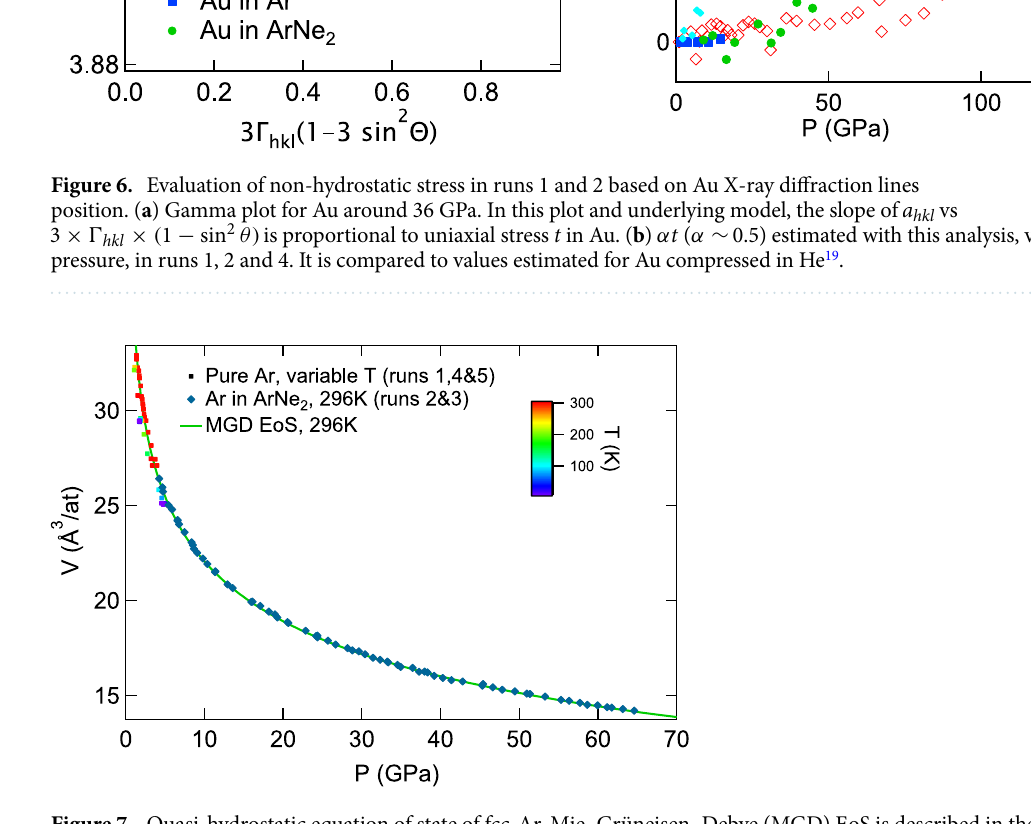
Figure 7. Quasi-hydrostatic equation of state of fcc-Ar. Mie–Grüneisen–Debye (MGD) EoS is described in the text and Table